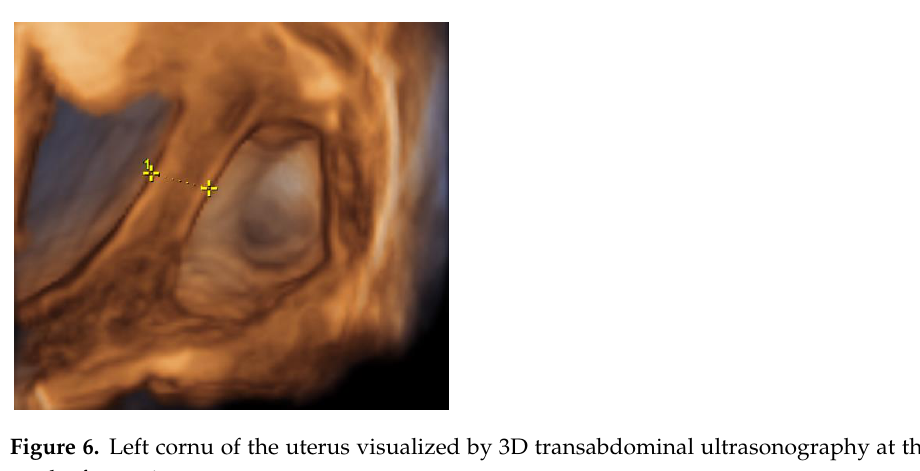
Figure 5. Left cornu of the uterus visualized by transabdominal ultrasonography at the 22nd week of gestation.